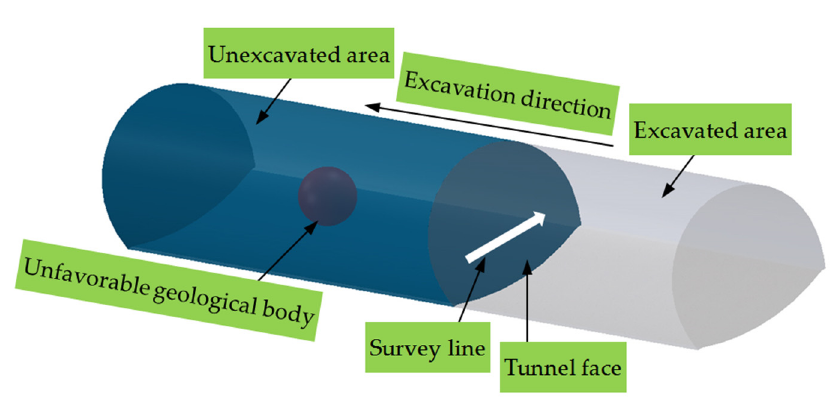
Figure 2. Schematic diagram of GPR detection on the tunnel face.